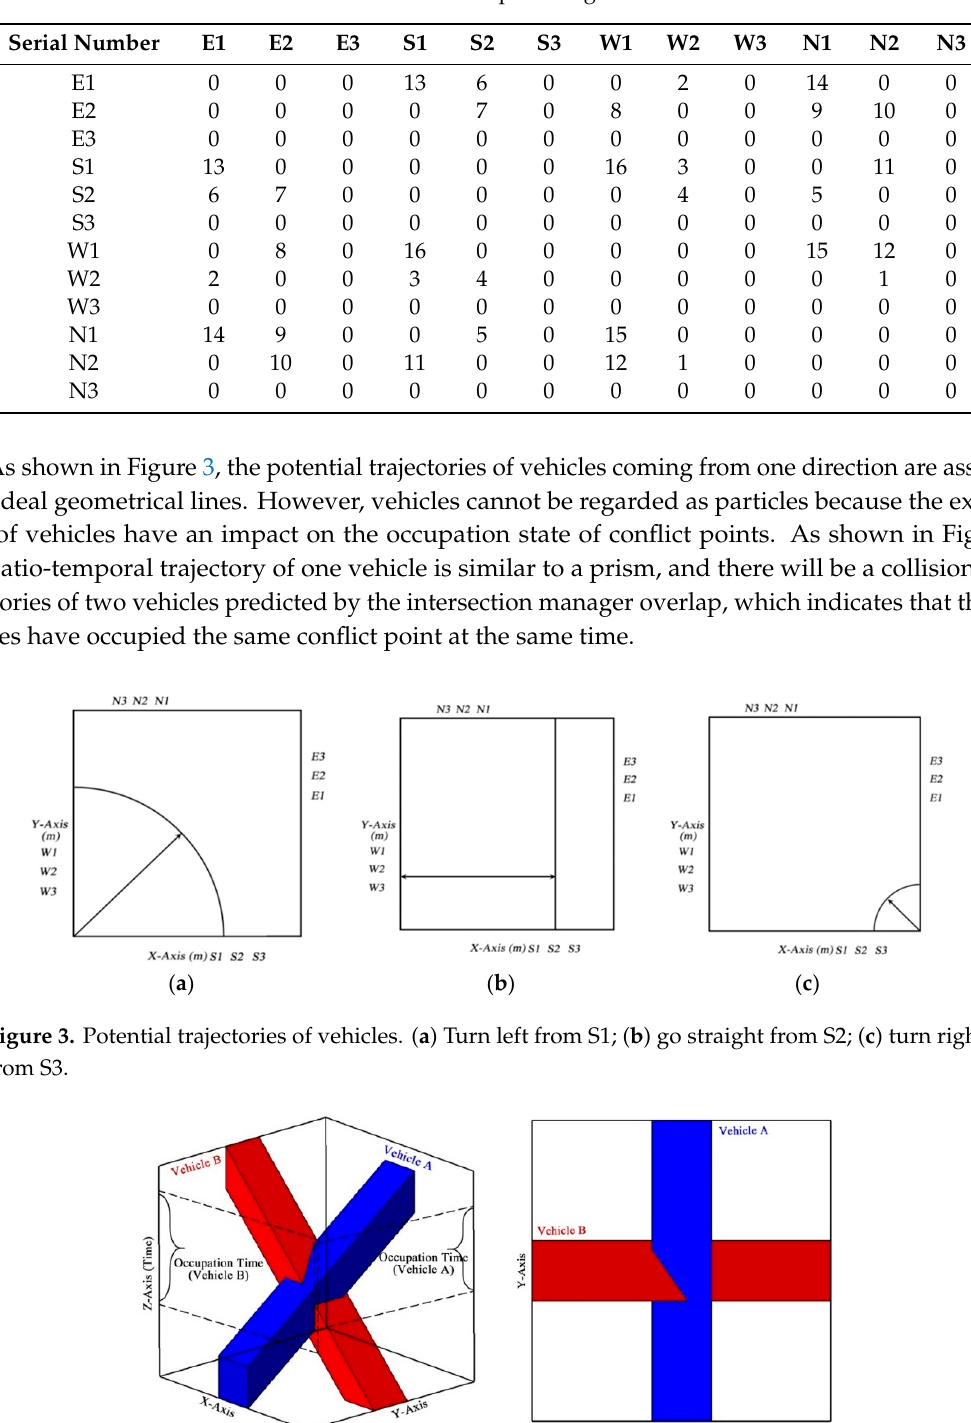
Table 1. Conflict relationships among di ff erent lanes.